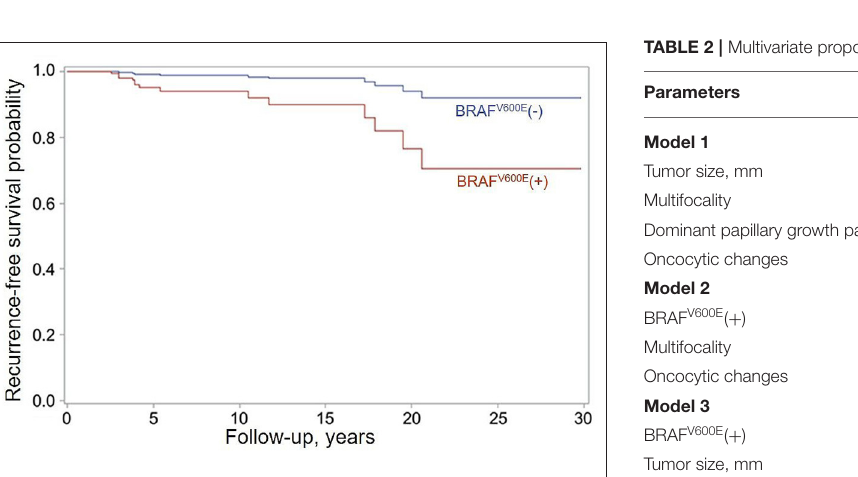
FIGURE 4 | Recurrence-free survival function estimates for patients with the BRAF V600E -positive (red) and BRAF V600E -negative (blue) PTCs obtained in the Firth’s-penalized Cox proportional hazard model adjusted for sex, tumor size, N and M categories, extrathyroidal extension, multifocality, lymphatic/vascular invasion, extent of thyroid operation, lymph node dissection, and RAI treatment. HR = 5.334 (95% CI, 1.196–24.746, p = 0.034) for the BRAF V600E -positive status.